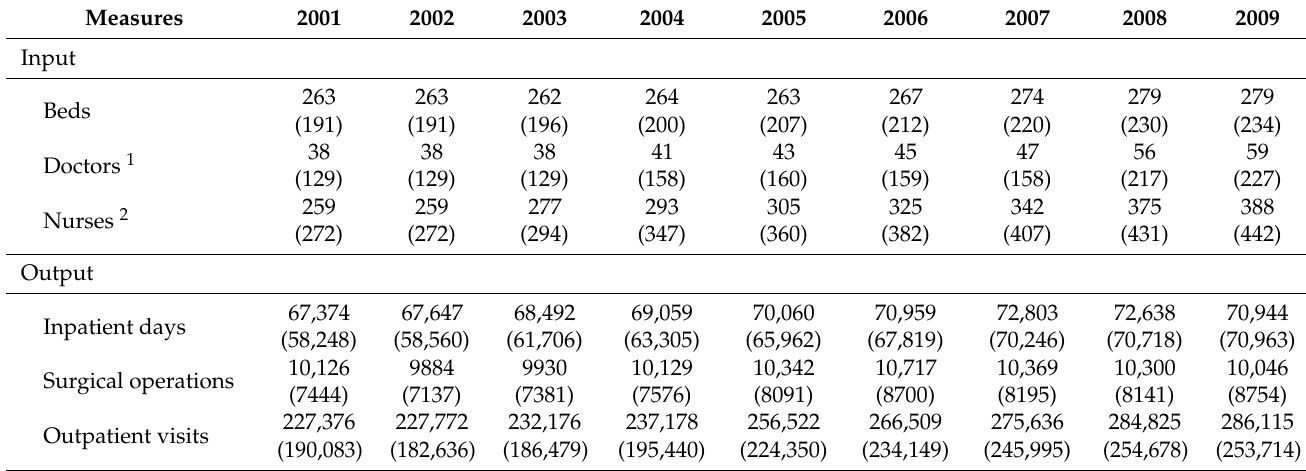
Table 1. Descriptive summaries of efficiency